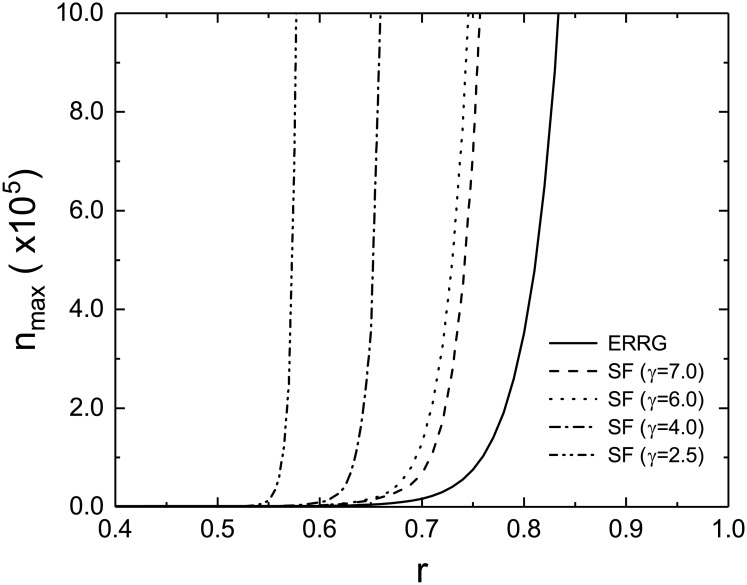
Maximum stable size nmax as a function of the load reduction parameter r.Three lines represent the results for the ERRG (solid line) and SF networks with the degree distributions P0(k) given by Eq (15) with γ = 7.0 (dashed line), 6.0 (dotted line), 4.0 (dashed-dotted line), and 2.5 (dashed-two dotted line). The minimum and maximum degrees kmin and kmax in Eq (15) are set as 1 and 80, respectively. All the results are calculated for 〈k〉0 = 5.0, m = 4.0, and a = 2.0.